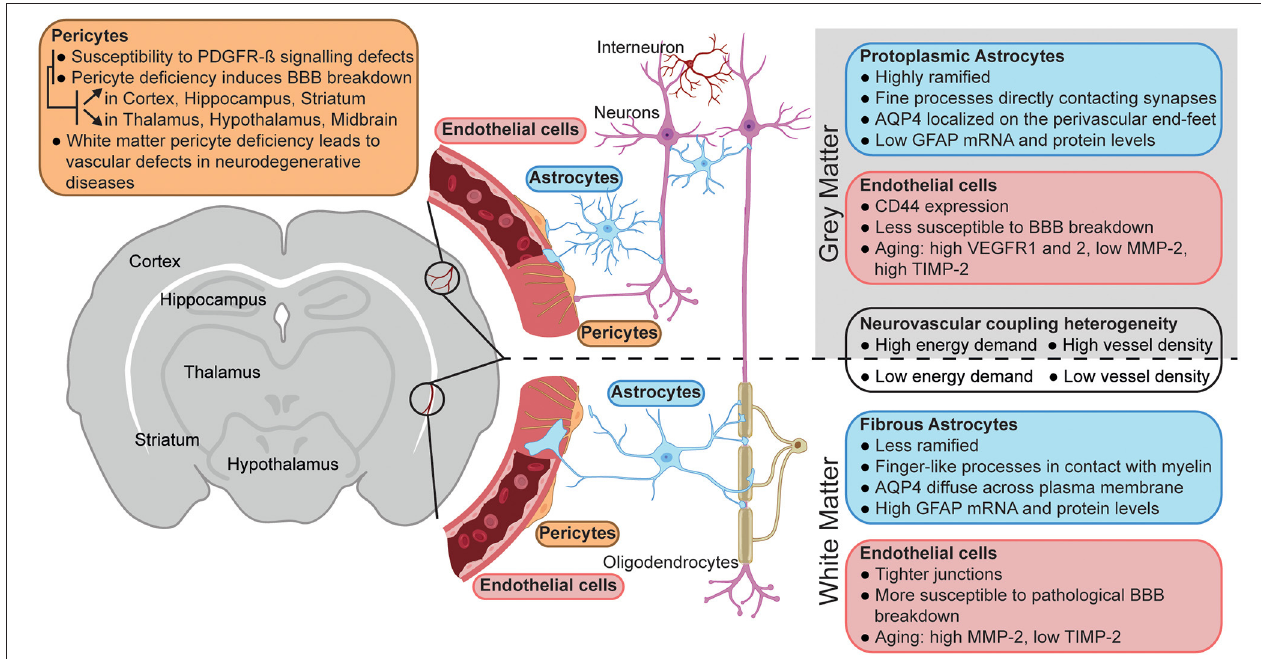
FIGURE 1 | Neurovascular unit heterogeneity between gray and white matter. Schematic representation of the main differences between the neurovascular unit of gray (top) vs. white matter (bottom). The figure was created using